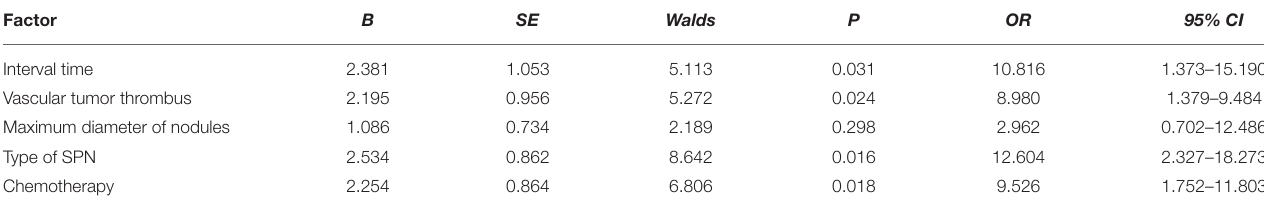
TABLE 5 | Multi-factor analysis of prognosis of patients with breast cancer combined with SPN. Factor B SE Walds P OR 95% CI Interval